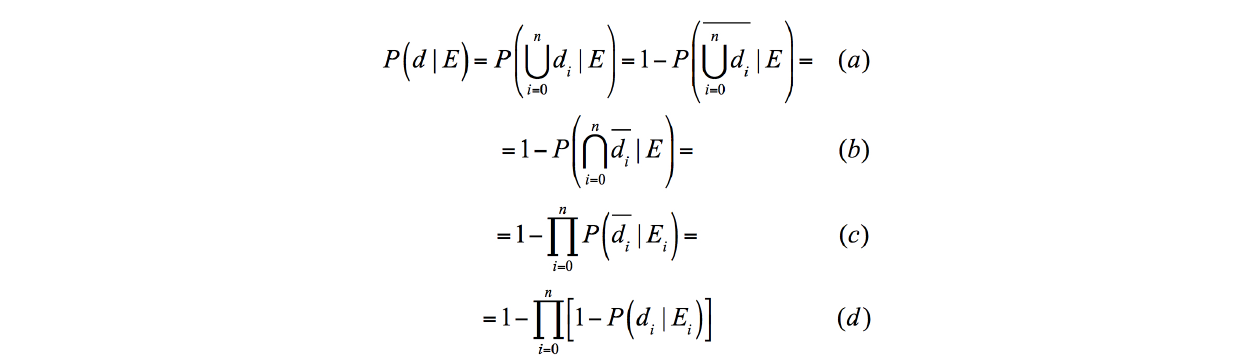
Figure 3. Probability to fall from risk factor specific probabilities.